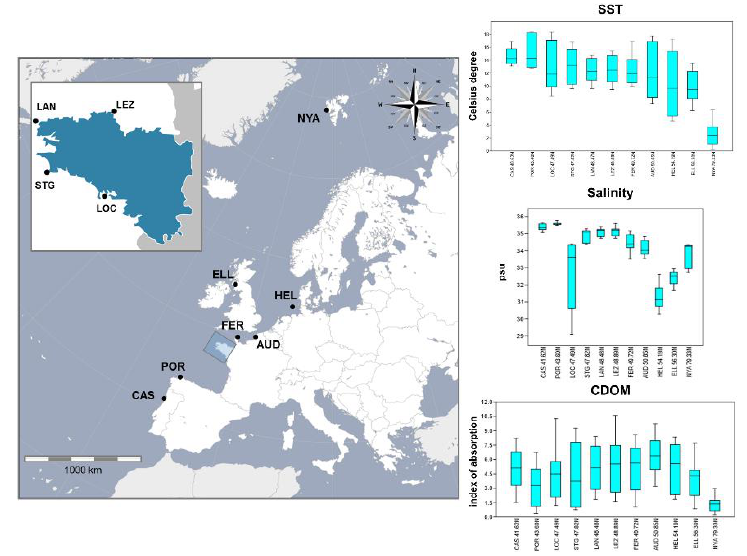
Figure 1. Map of the 11 sampling sites for the S. latissima sporophytes analyzed in this study. The insert shows the precise position of the four Brittany (France) sampling localities. See Supplementary Materials Table S1A for the detailed description of the 11 sampling sites. The box-plots shown on the right-hand side of the map display within-site variation for three environmental variables: sea surface temperature (SST), salinity, and chromophoric dissolved organic material (CDOM). The localities (x-axis) are ordered by latitude (south to north from left to right).